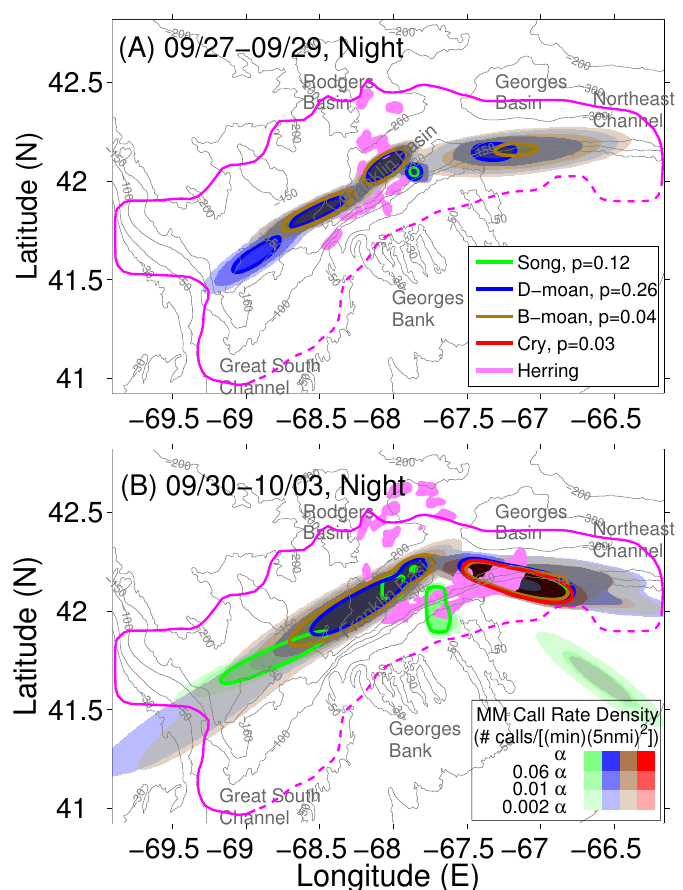
Figure 8. Nighttime spatial distributions of call rates for different humpback vocalization types and Atlantic herring population. The data are averaged over nighttime hours for ( A ) from 27–29 September 2006 and ( B ) from 30 September to 3 October 2006. All other contours are similar to Figure